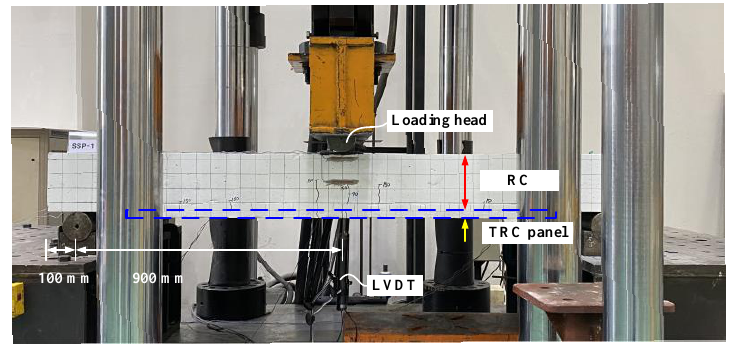
Figure 8. Test set-up for three-point loading.